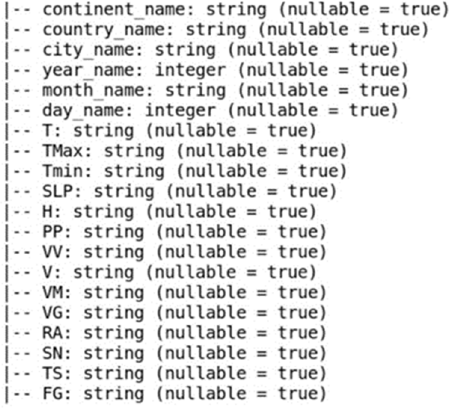
Figure 14. An example schema representing climate information.